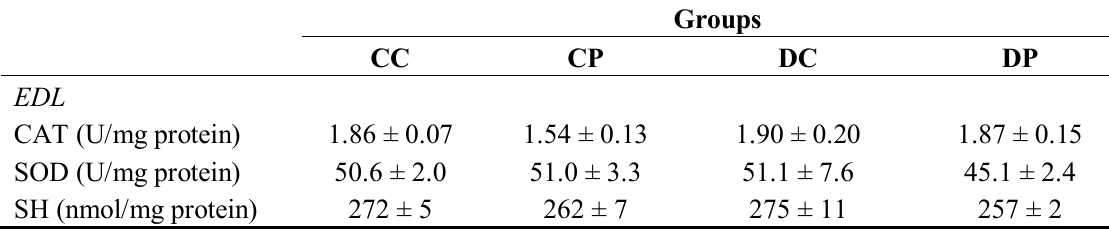
Table 2. Antioxidant enzymes activities and sulfhydryl groups in EDL muscle after 12 weeks of treatment (means ±